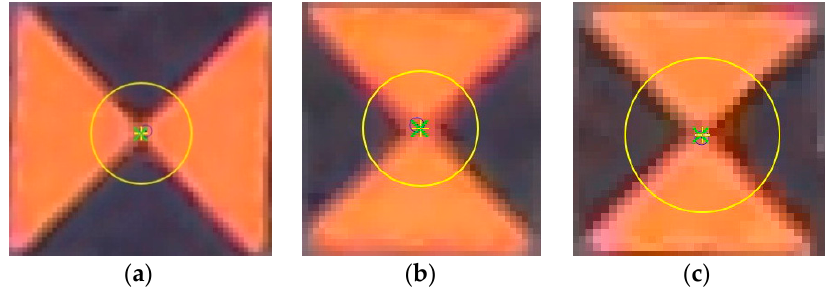
Figure 8. Screen shots with a control point image in Pix 4D Mapper (No. 229) positioned approximatively in the calibration field center ( a ) 23 m height, ( b ) 28 m and ( c ) 35 m height. Remote Sens. 2018 , 10 , x FOR PEER REVIEW